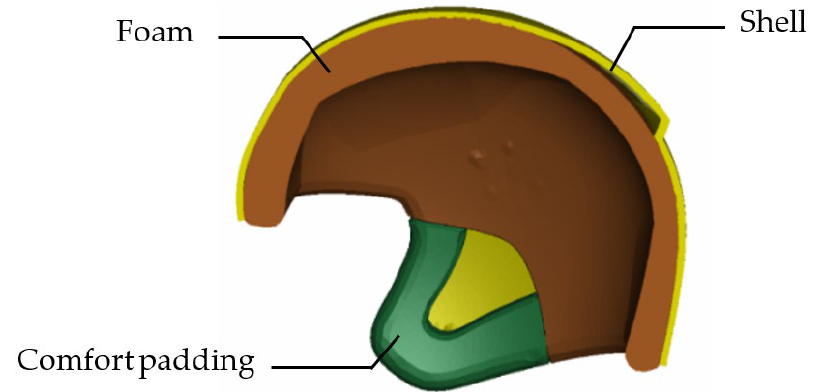
Figure 2. Helmet structural model and its components.